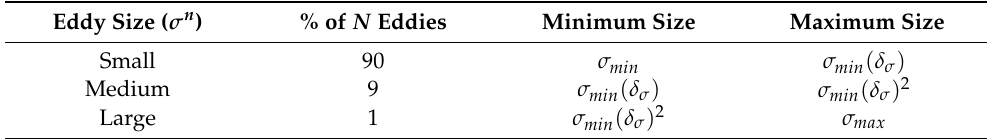
Table 1. Eddy Bin Size